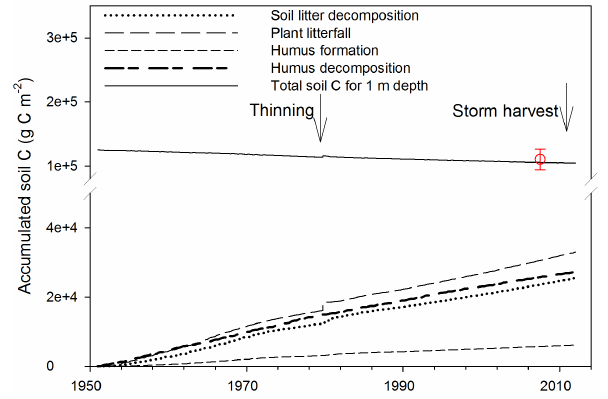
Figure 3. Simulated development of major soil C pools in the first metre of soil, from 1951 to 2011. The red circle shows the mea- sured total soil C in 2007 ( ± 95% confidence intervals) by Meyer et al. (2013).